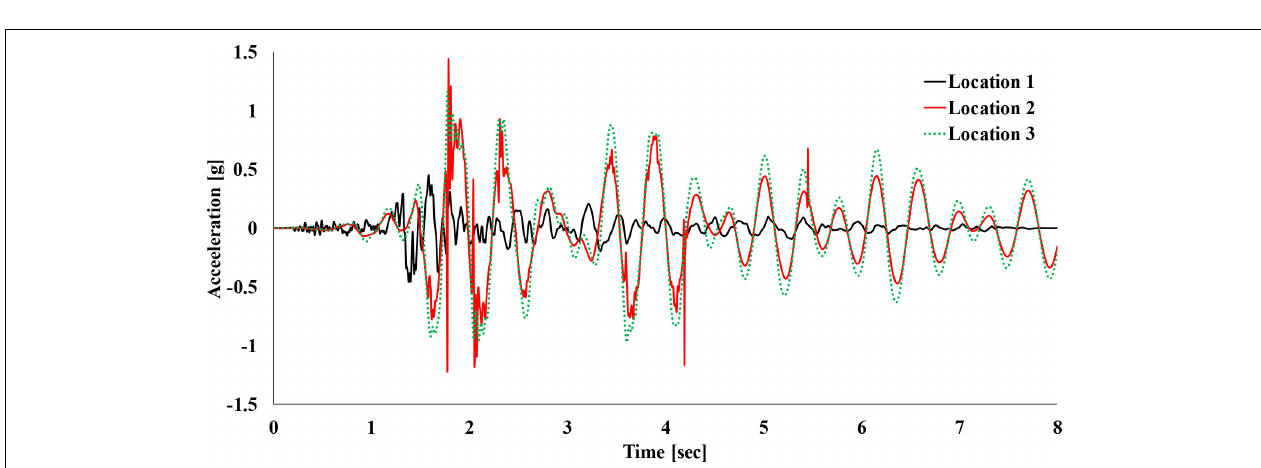
FIGURE 12 | Acceleration time-histories at the three points of interest (see Figure 1B ) for the Northern California record for the unanchored ( µ 1 = 0.4) squat tank for soft soil conditions.